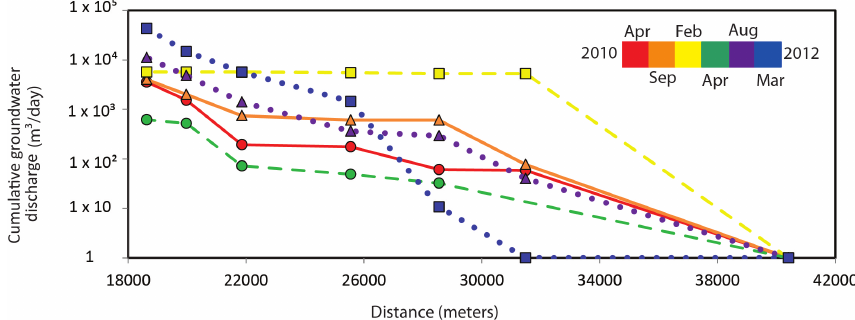
Fig. 9. Cumulative groundwater discharge to the Tambo River from Cl mass balance. April 2010=solid line with circles, Septem- ber 2010=solid line with triangles, February 2011=dashed line with squares, April 2011=dashed lines with circles, August 2011=dotted line with triangles, March 2012=dotted line with